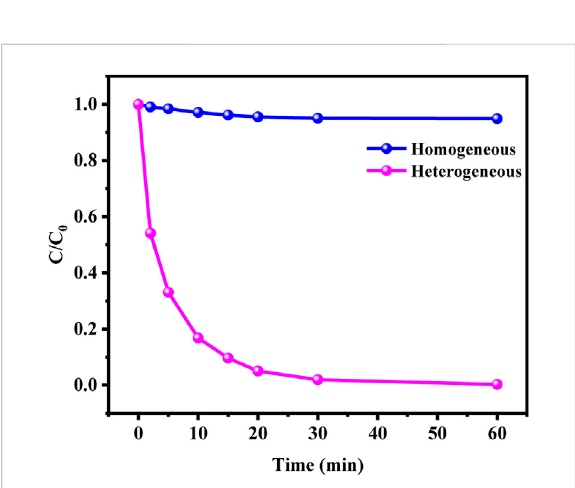
FIGURE 9 Homogeneous/Heterogeneous Fenton degradation of